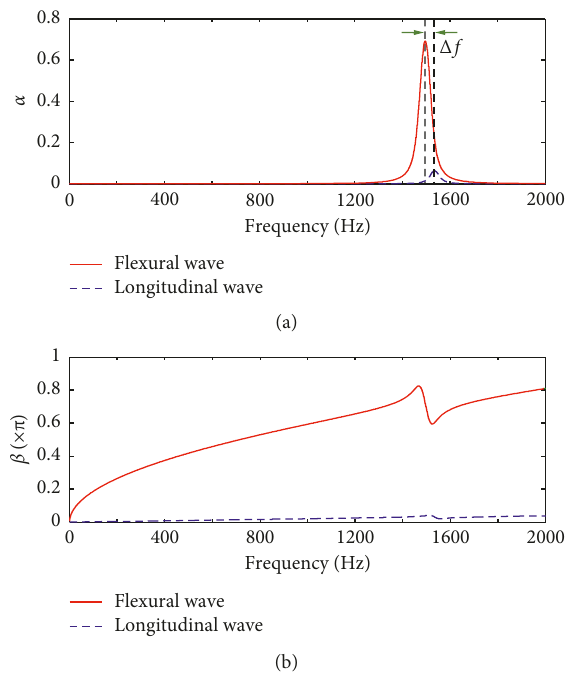
Figure 6: Propagation constant with shunt damping.